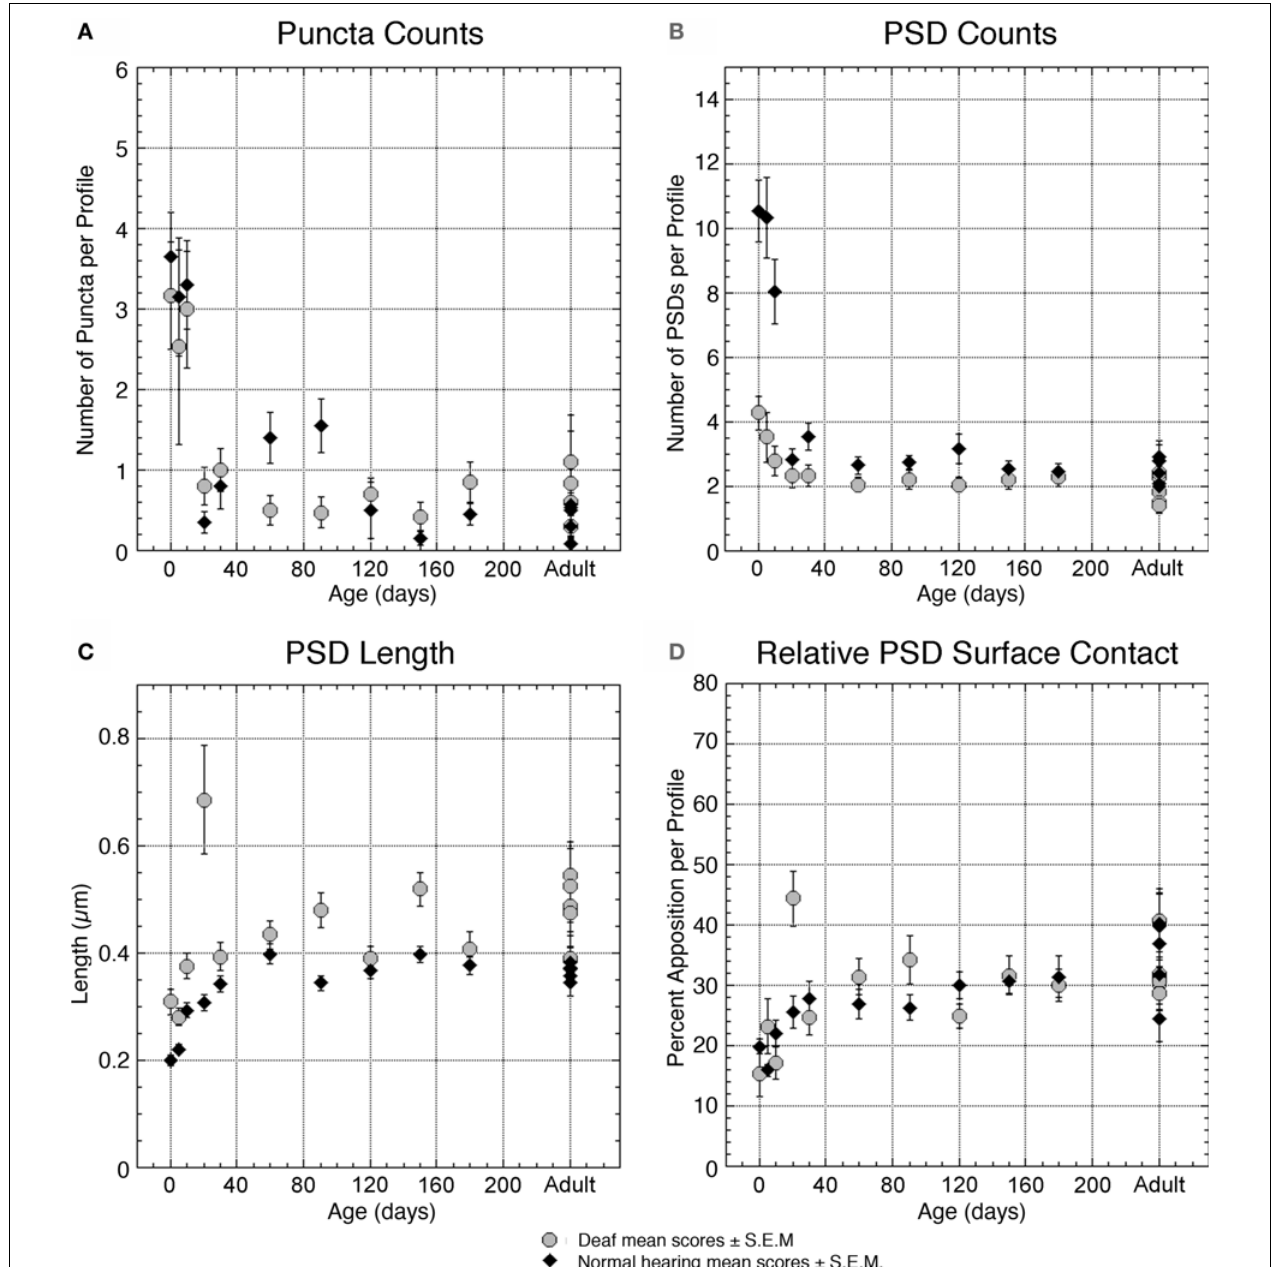
almost double in length from birth to adulthood, with deaf PSDs consistently larger than those of normal animals. (D) The relative amount of PSD contact between the endbulb and SBC exhibits no pronounced changes as a result of deafness. Each point represents an average of multiple measures collected from two animals at all time points except adult, where each point represents the average for one animal. Data values from normal hearing cats are replotted from Ryugo et al.